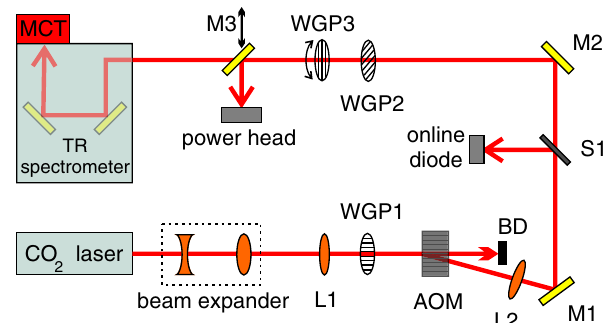
FIG. 15. Schemetic of the CO 2 calibration setup: The beam expander consists of a defocusing and a focusing ZnSe lens, enlarges the beam diameter from ∼ 1 to ∼ 10 mm. The beam is focused on the AOM crystal by L1 and is polarized by WGP1. The deflected pulsed beam under 161 mrad deflection angle is recollimated by L2. Following the mirror M1, a fraction of the beam is reflected by the 1 mm thick silicon wafer S1 into a fast photodiode to monitor the laser pulse length. Transmission through the S1 passes WGP2 set at 45° angle and further passes the adjustable WGP3 which is utilized to define the output polarization of the setup. The mirror M3 can be either inserted into the beam for power measurement or removed for spectro- meter